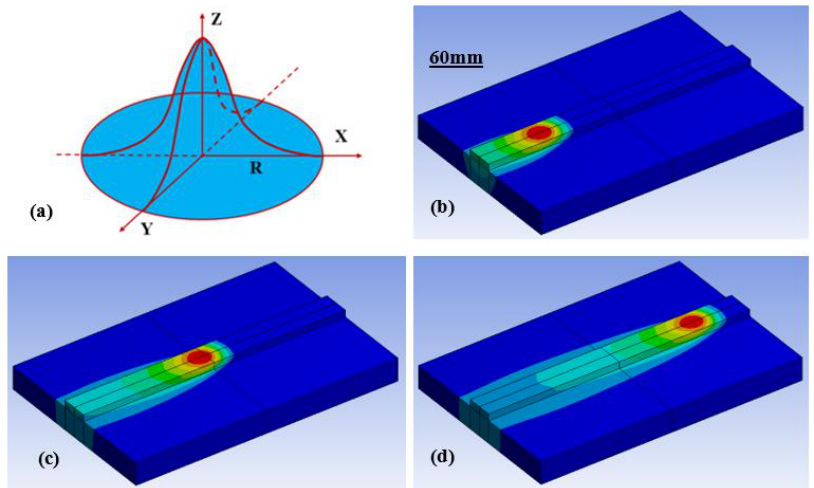
Figure 2. Heat source model and preliminary simulation results. ( a ) Gaussian heat density distribu- tion, ( b ) t = 3 s, ( c ) t = 6 s, ( d ) t = 9 s.